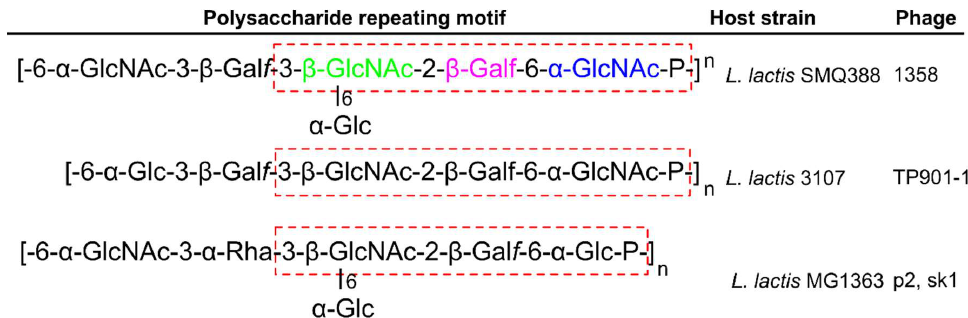
units of strains MG1363 and SMQ-388 [22,73], and the phosphopentasaccharide unit of strain 3107 [121]. Dotted red box highlights the core trisaccharide for each pellicle; for strain MG1363, colors pellicle repeats. Abbreviations: GlcNAc, N -acetylglucosamine; Galf, Galactofuranose; Glc, Glucose; Rha,